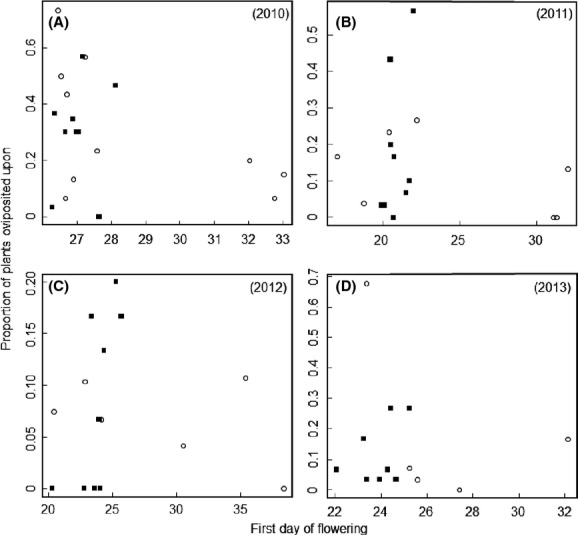
Relationship between first flowering day and the proportion of plant individuals in tetraploid (filled squares) and octoploid (open circles) populations of Cardamine pratensis oviposited upon by the butterfly herbivore Anthocharis cardamines in (A) 2010 (19 populations), (B) 2011 (16 populations), (C) 2012 (15 populations), and (D) 2013 (13 populations). None of the relationships are significant at P = 0.05.